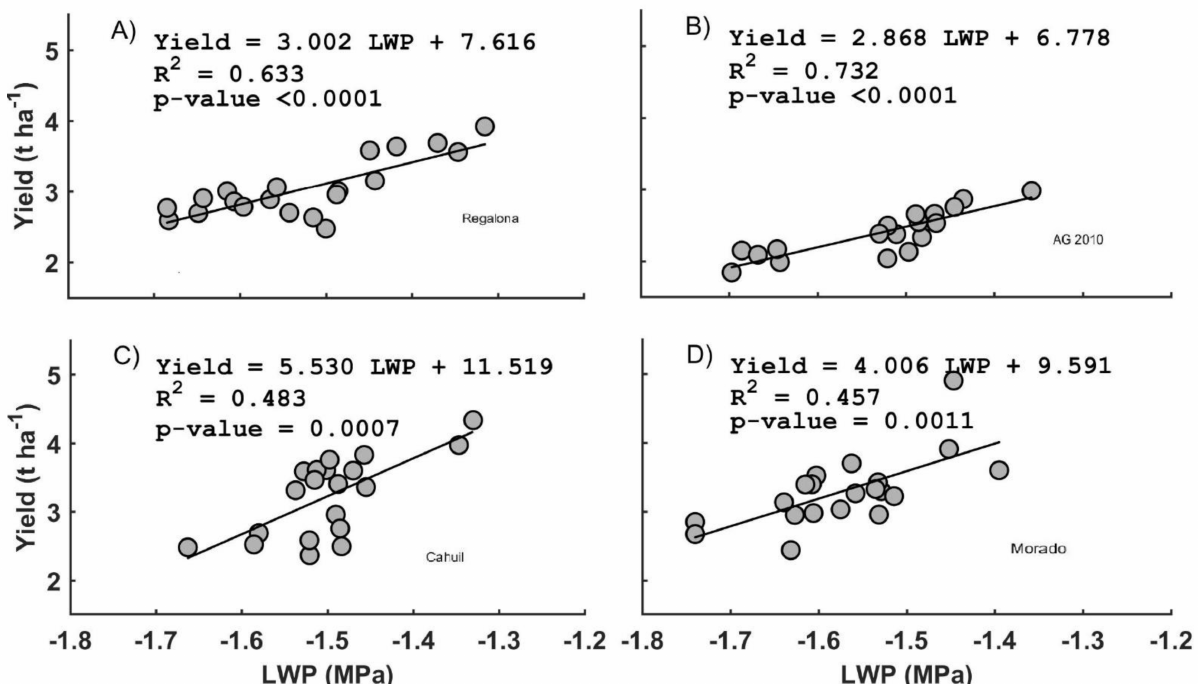
Figure 6. Relationship between seed yield and leaf water potential (LWP) at midday for four quinoa genotypes: ( A ) Regalona, ( B ) AG 2010, ( C ) Cahuil, and ( D ) Morado, season 2015/2016. Each point represents the yield of an experimental unit and the average of eight LWP measurements made from grain filling throughout the physiological maturity stage at the same experimental unit.